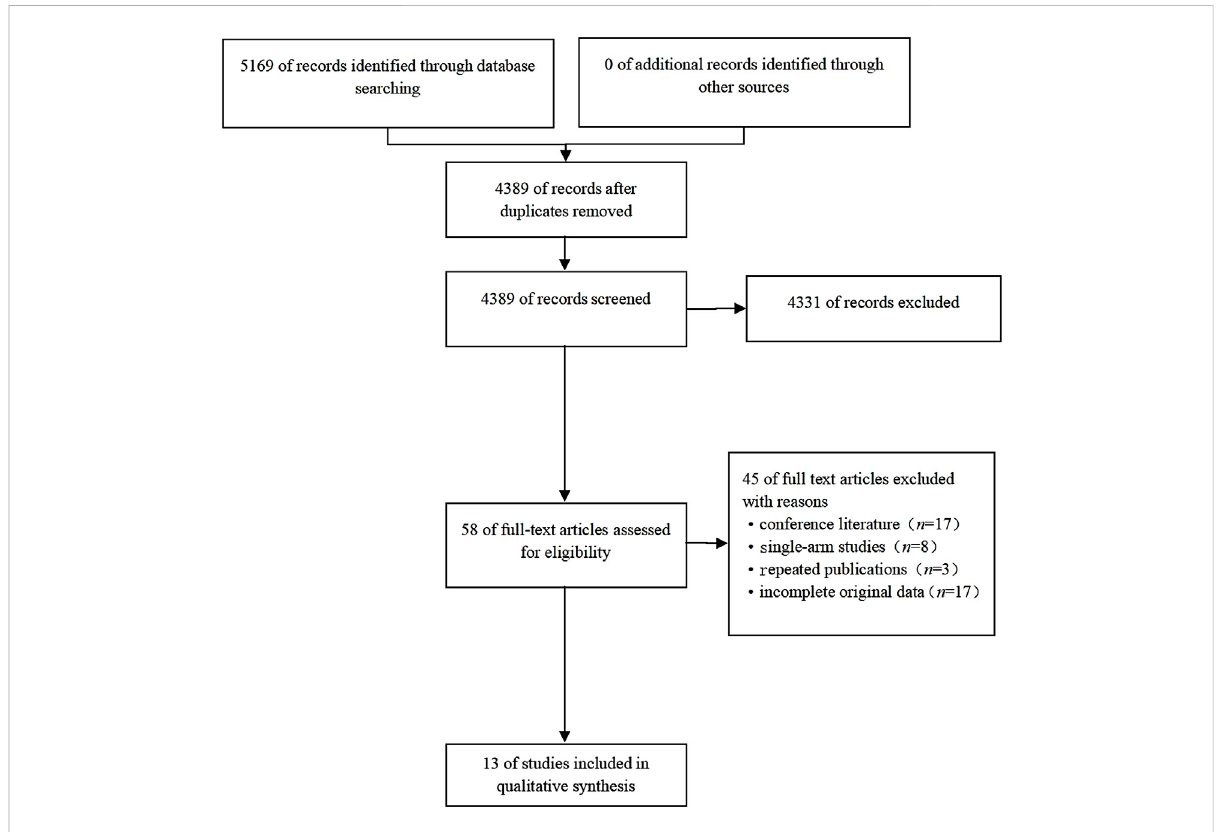
FIGURE 1 Flow chart of the search